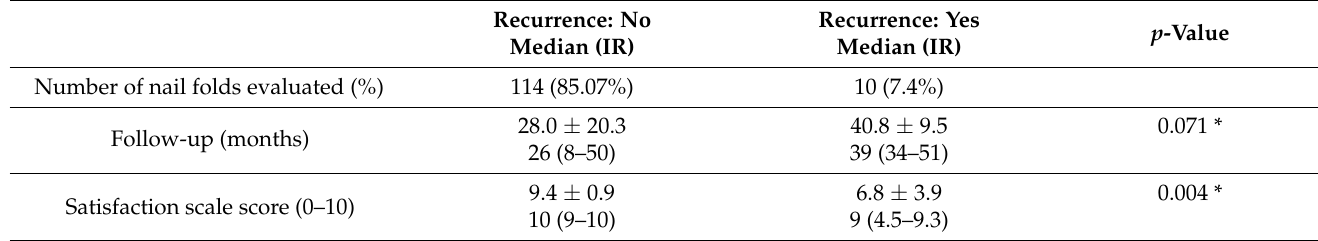
Table 5. Recurrencein relation to the number of procedures